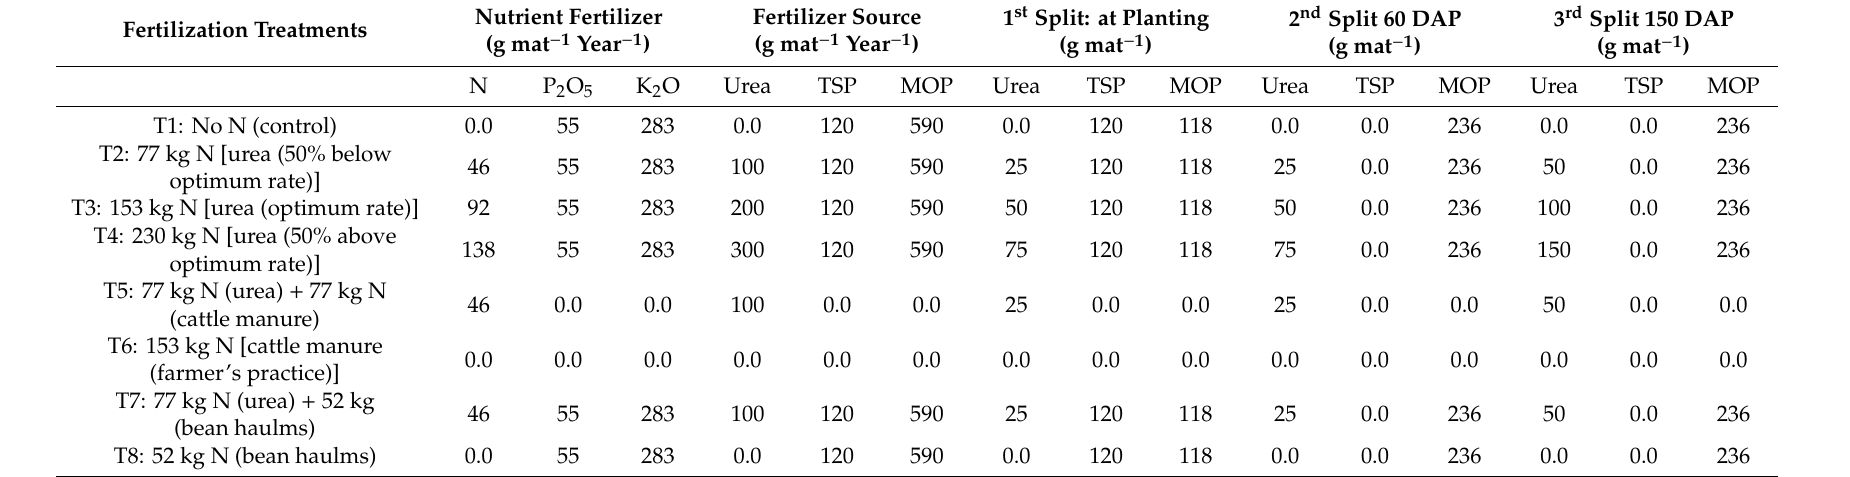
Table 3. Mineral fertilizers applied mat − 1 in each